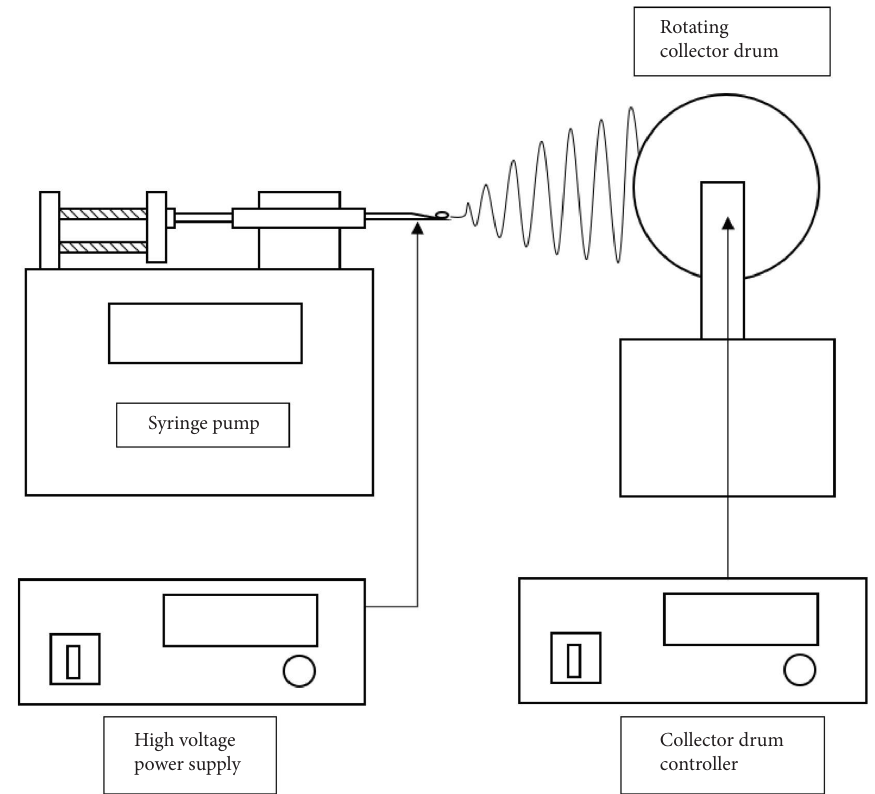
Figure 2: Illustration of electrospinning equipment setup to obtain PVB/bentonite nanofbers.